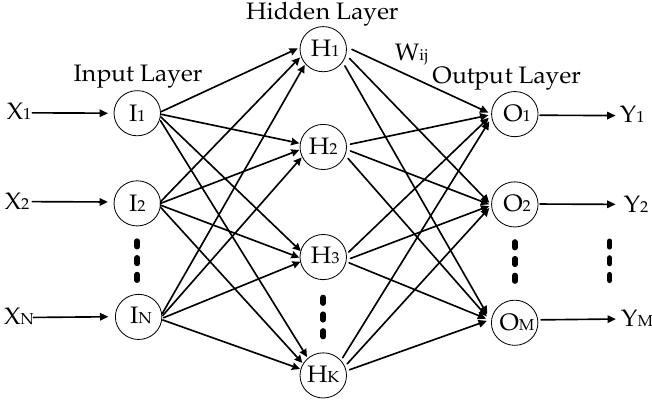
Figure 10. Structure of a radical basis function artificial neural network (RBF ANN).